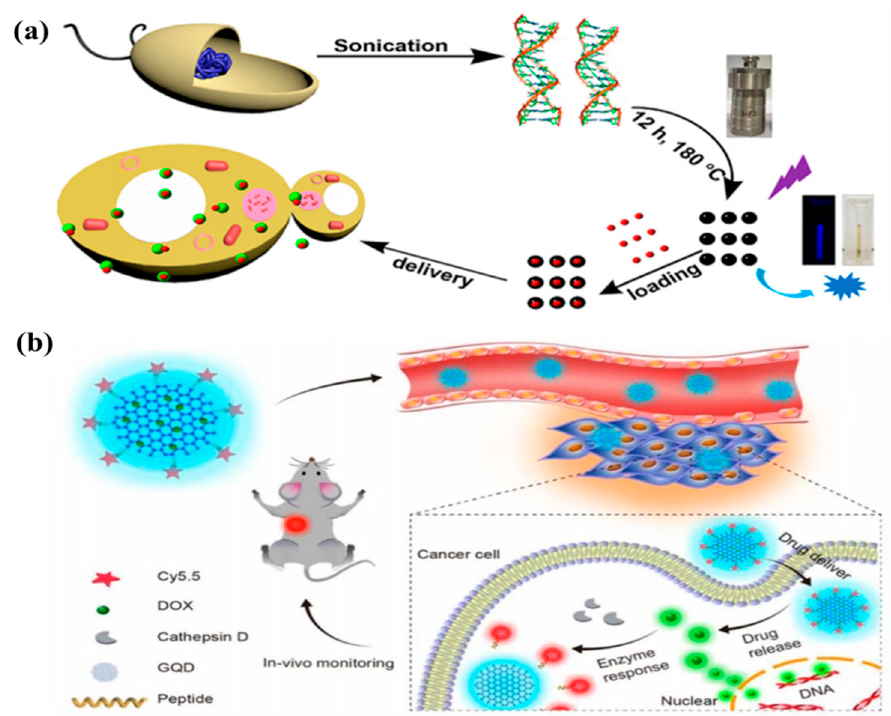
Figure 22. ( a ) Schematic image of DNA-BCD synthesis and application in drug delivery [166]. Copyright 2015, American Chemical Society. ( b ) Strategy of CD-based theranostic agent in vivo monitoring [167]. Copyright 2017, American Chemical Society.